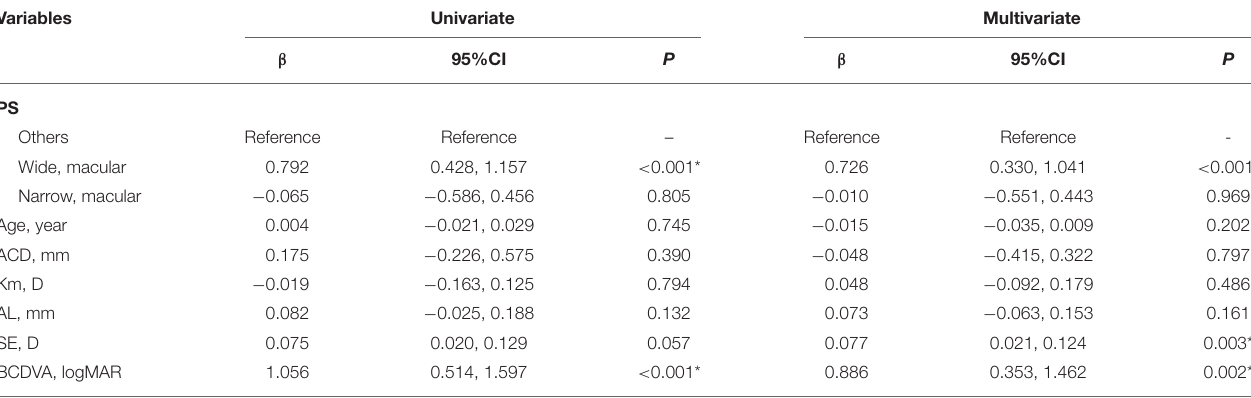
TABLE 3 | Univariate and multivariate analyses of risk factors for postoperative refractive errors.